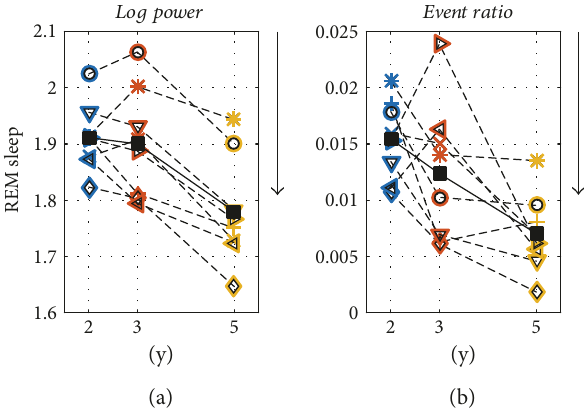
Figure 5: (a) Mean power (log10) and (b) event ratios in the 1.25 – 5.0Hz range at three longitudinal time points (2, 3, and 5 years of age) to illustrate the developmental change in REM sleep. For details; see Figure